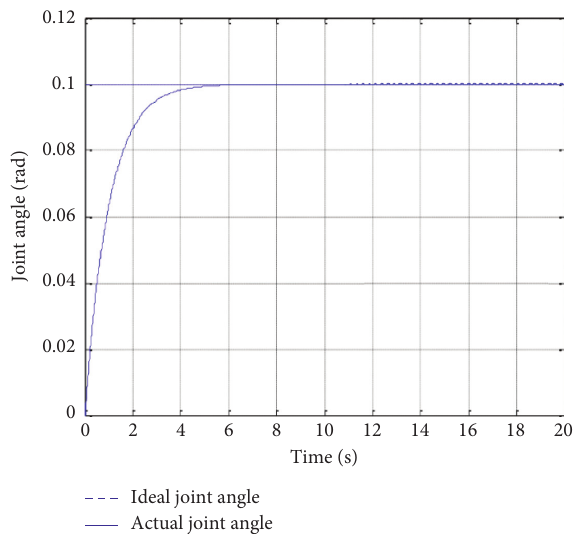
Figure 8: Joint angular displacement of the flexible manipulator.